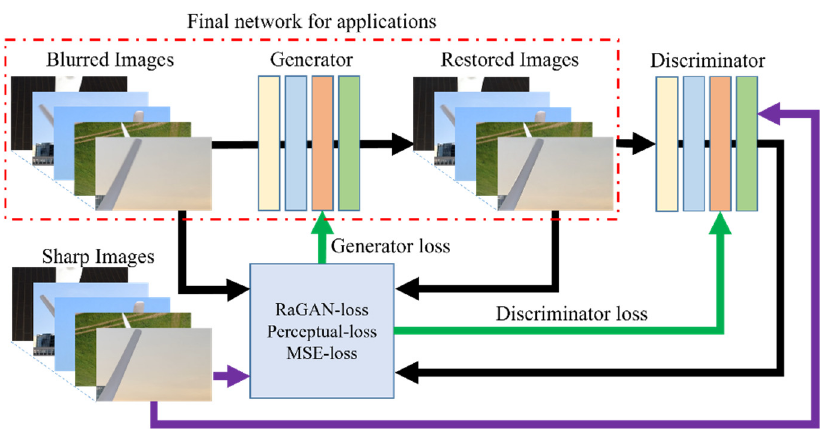
Figure 9. Flowchart of DeblurGANv2-based motion deblurring of WTB images.